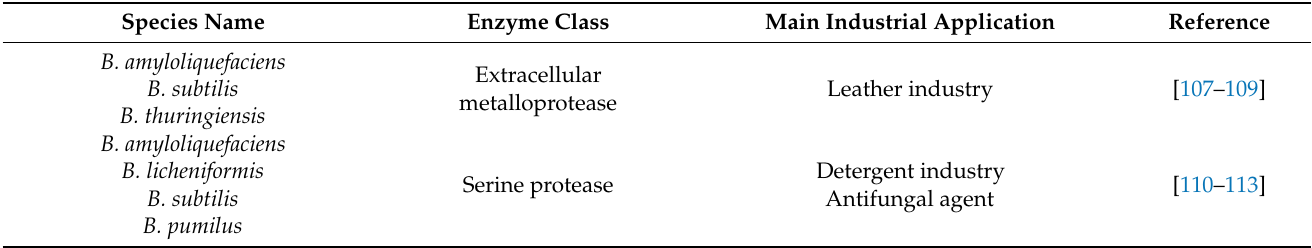
Table 2. Most important enzymes produced by various Bacillus